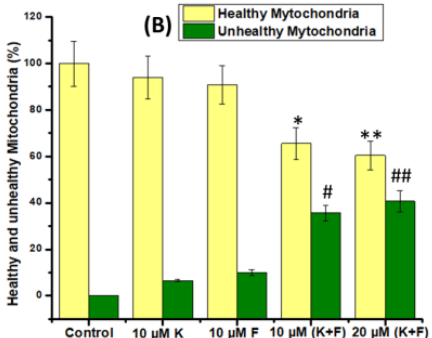
Figure 4. ( A ) Mitochondrial membrane potential measurement of MDA-MB-231 cells 24 h after treatment with 10 μM K, 10 μM F, 10 μM (K + F), and 20 μM (K + F) by flow cytometry. ( B ) Bar plot of ( A ) healthy mitochondria; * denotes control versus 10 μM (K + F); ** denotes control versus 20 μM (K + F) unhealthy mitochondria; # denotes control versus 10 μM (K + F); ## denotes control versus 20 μM (K + F). Statistical significance: * p < 0.05, ** p < 0.01.